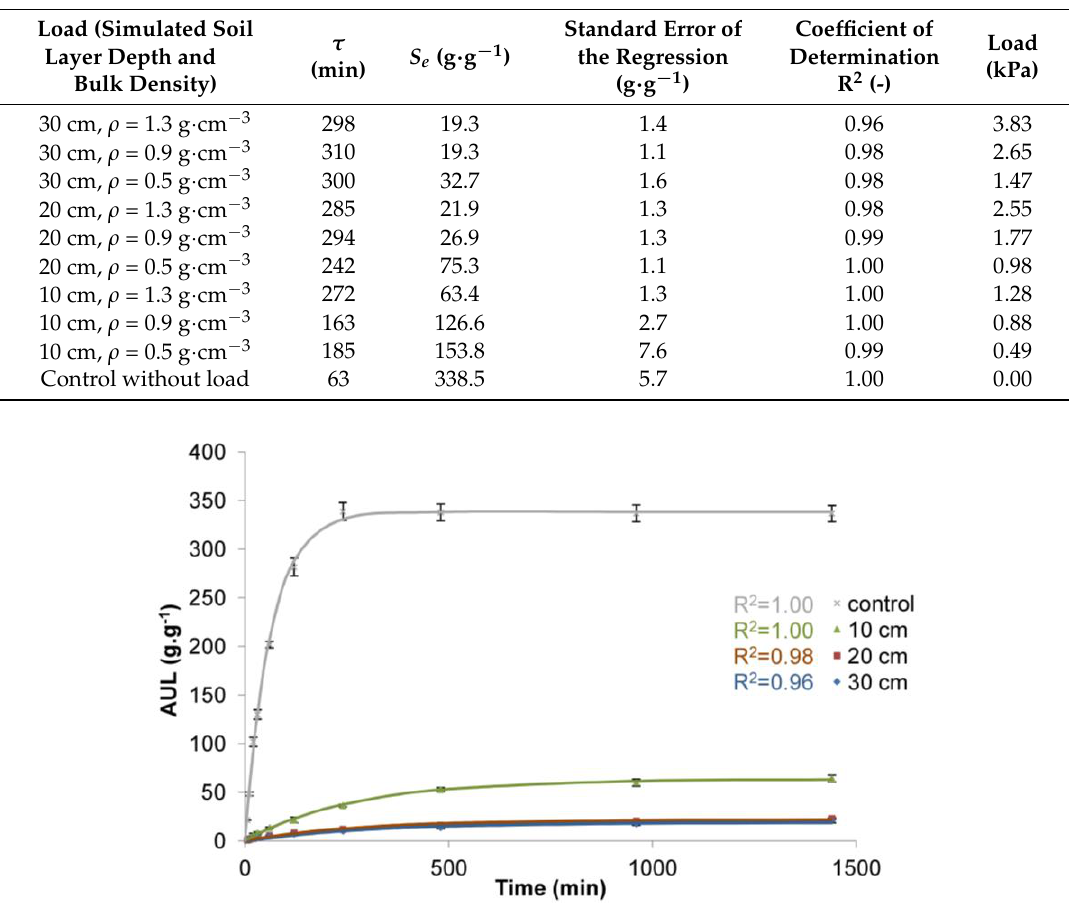
Figure 4. Time dependence of the AUL values for superabsorbent polymer loaded with soil of a bulk density of 1.3 g ∙ cm −3 and 10, 20, and 30 cm deep soil layers.